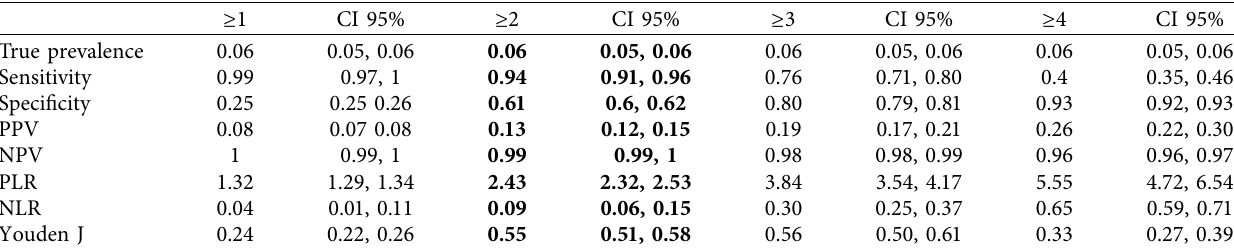
Table 5: Predictive characteristics of the SPS. Predictive characteristics for each possible point threshold of the simple prognostic score, with the chosen threshold of ≥ 2. Corresponding contingency tables can be found in the online